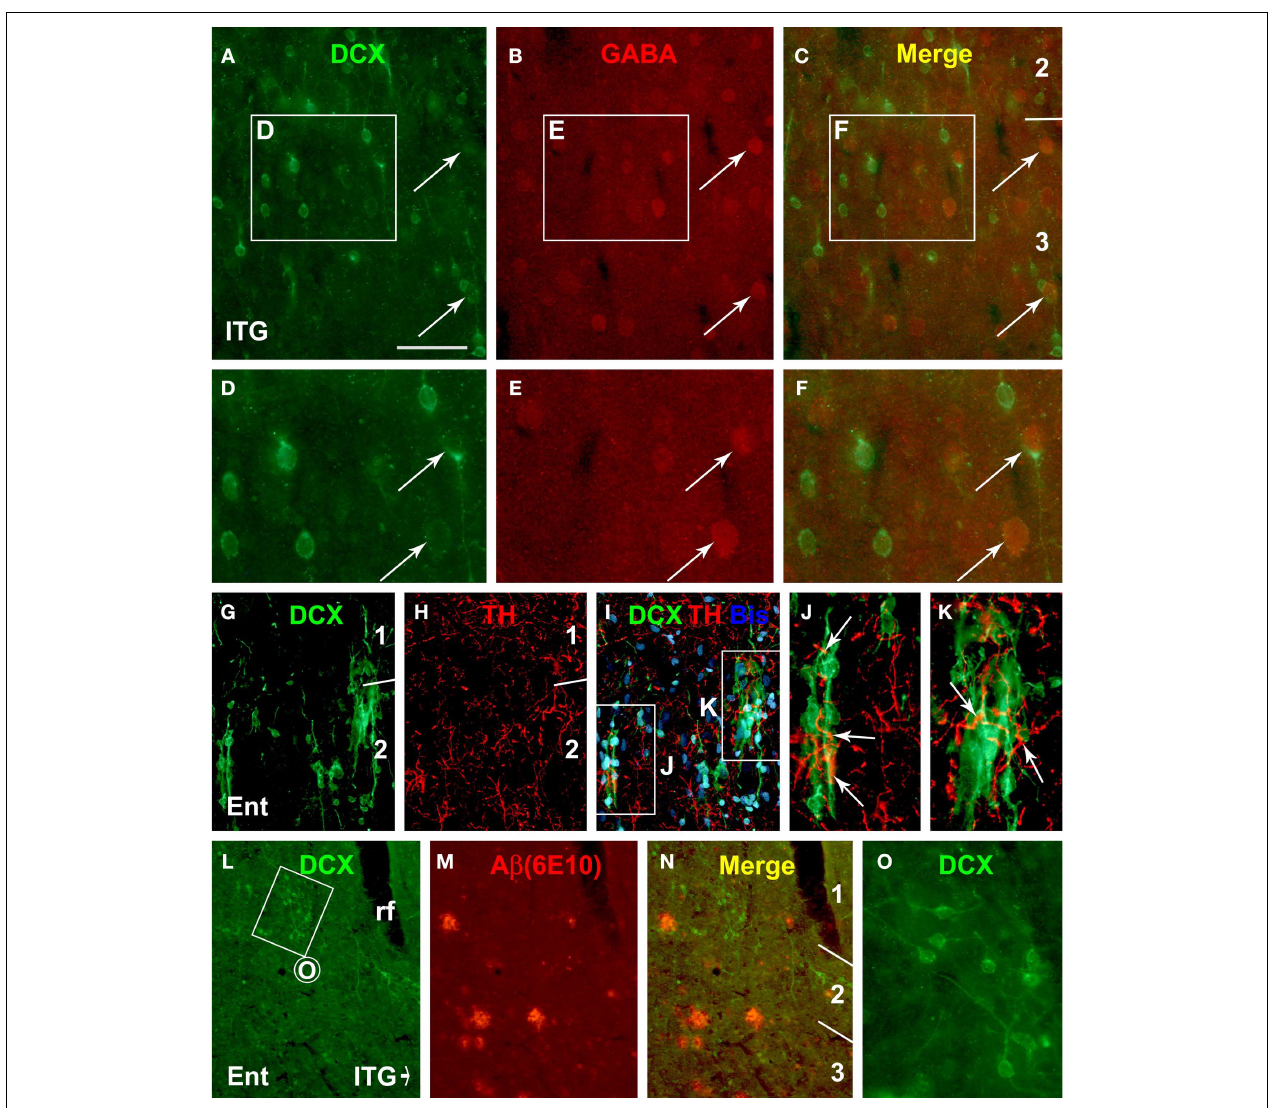
FIGURE 7 | Representative immunofl uorescent images from the 19-year- old (A–K) and the 34-year-old (L–O) monkeys depicting double labeling of DCX with γ -aminobutyric acid (GABA), tyrosine hydroxylase (TH) and β - amyloid peptide (A β , 6E10 staining) in the cortical areas as indicated. GABA immunoreactivity is detectable in a small subset of relatively large DCX + cells